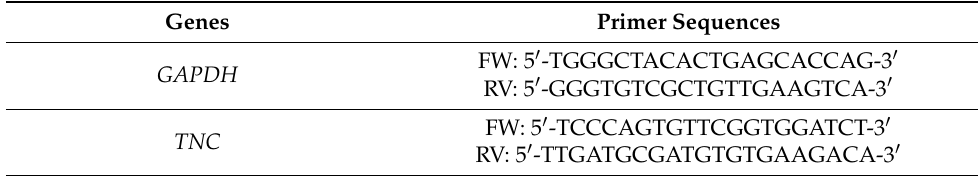
Table 1. Primer sequences used in RT-qPCR